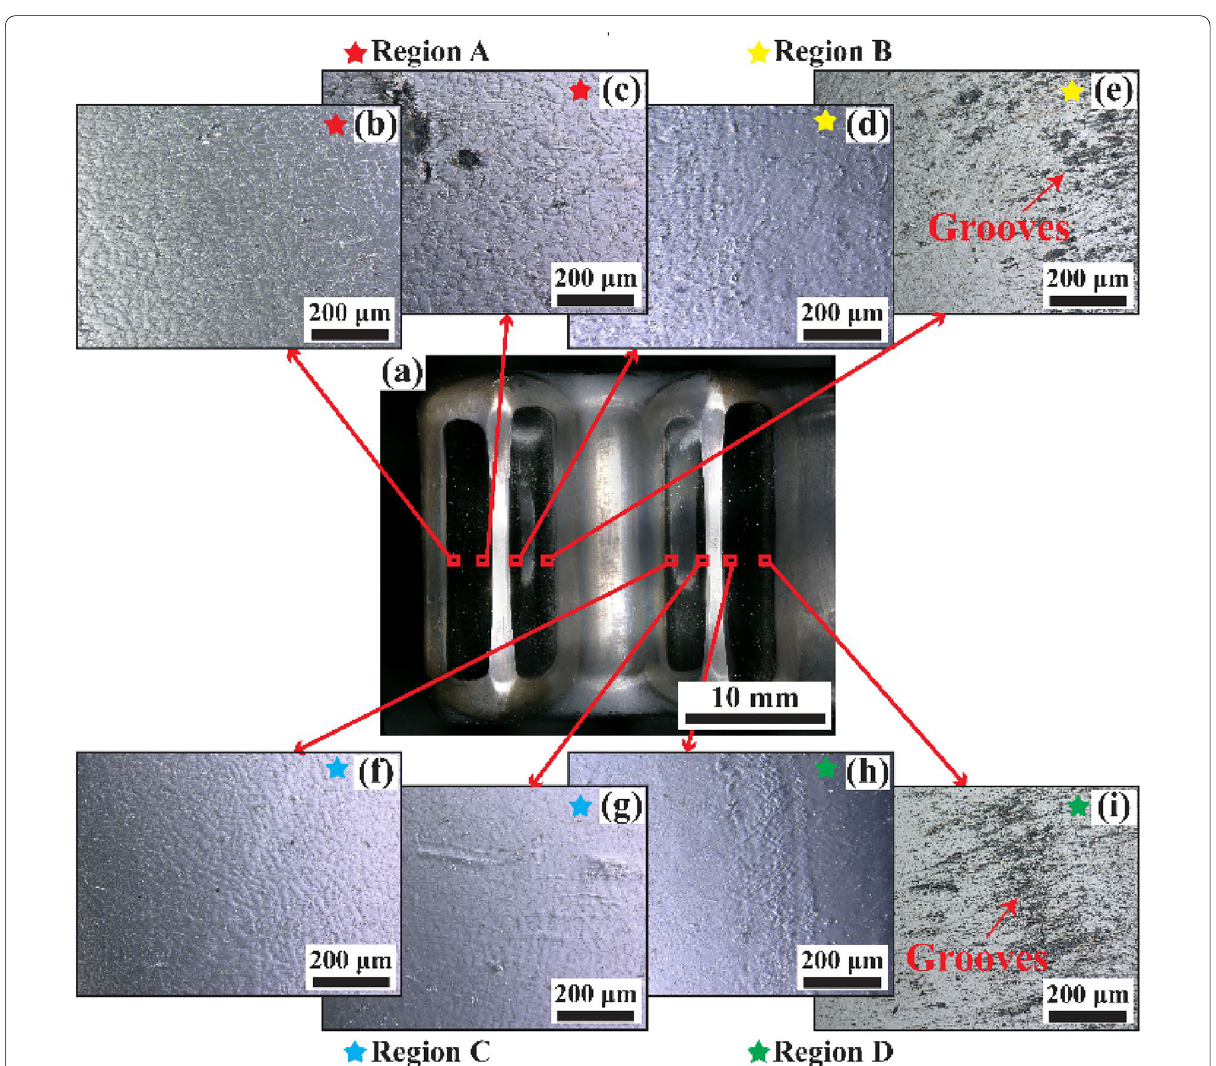
Figure 11 Worn morphologies on various claw